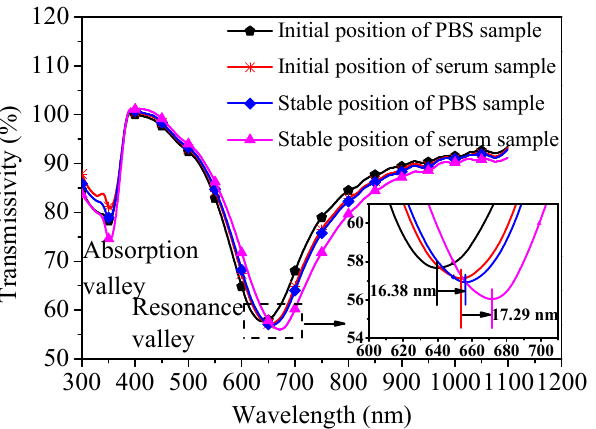
Figure 9. Resonance spectrum of the sensor obtained in detecting PBS sample and serum sample.